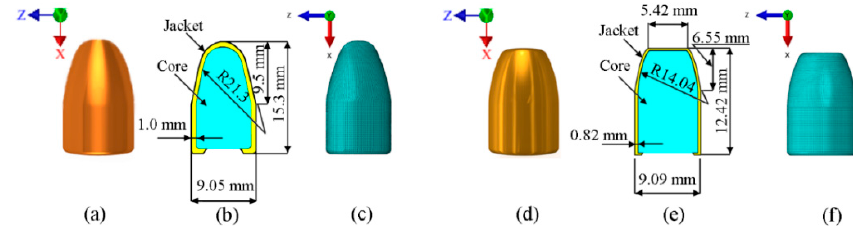
Figure 3. Projectile geometry: ( a ) 9 mm Parabellum, ( b ) dimensions, ( c ) discrete model, ( d ) 0.38 Special, ( e ) dimensions, ( f ) discrete model.